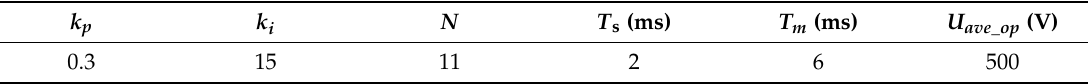
Table 3. Parameters of voltage and economical regulator.